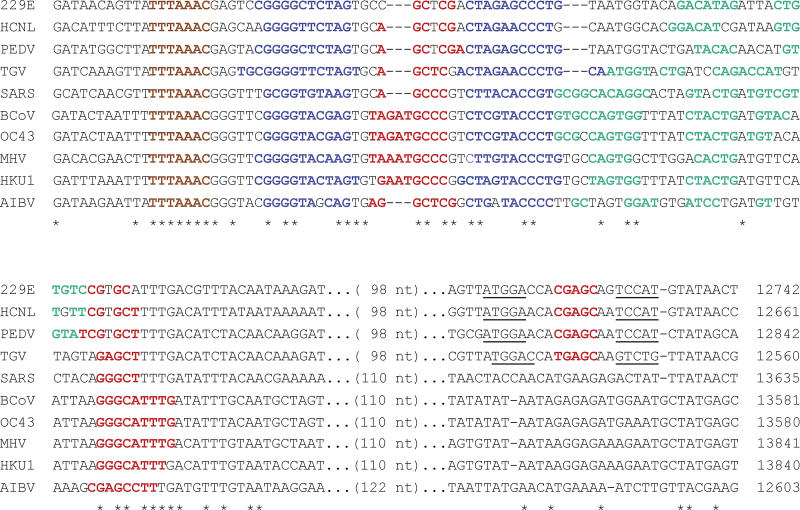
Multiple Sequence Alignment of the SARS-CoV −1 PRF with Nine Homologous Signals Found in Other Coronavirus GenomesAIBV, avian infectious bronchitis virus; BCoV, bovine coronavirus; HCoV-229E, human coronavirus 229E; HCoV-HKU1; HCoV-NL63, human coronavirus NL63; HCoV-OC43, human coronavirus OC43; MHV, murine hepatitis virus; PEDV, porcine epidemic diarrhea virus; SARS, SARS coronavirus; TGV, transmissible gastroenteritis virus. Heptameric slippery sites are indicated in brown; dashes indicate gaps in the sequence alignments; basepairing positions involved in the consensus first, second, and third helices are denoted by blue, red, and green nucleotides, respectively. Downstream regions homologous to the kissing loop known to promote frameshifting in HCoV-229E [16,17]. HCoV-229R, HCoV-NL, PEDV, and TGV are also highlighted in red with the flanking stem-forming sequences underlined. Asterisks indicate perfectly conserved positions in primary sequence.